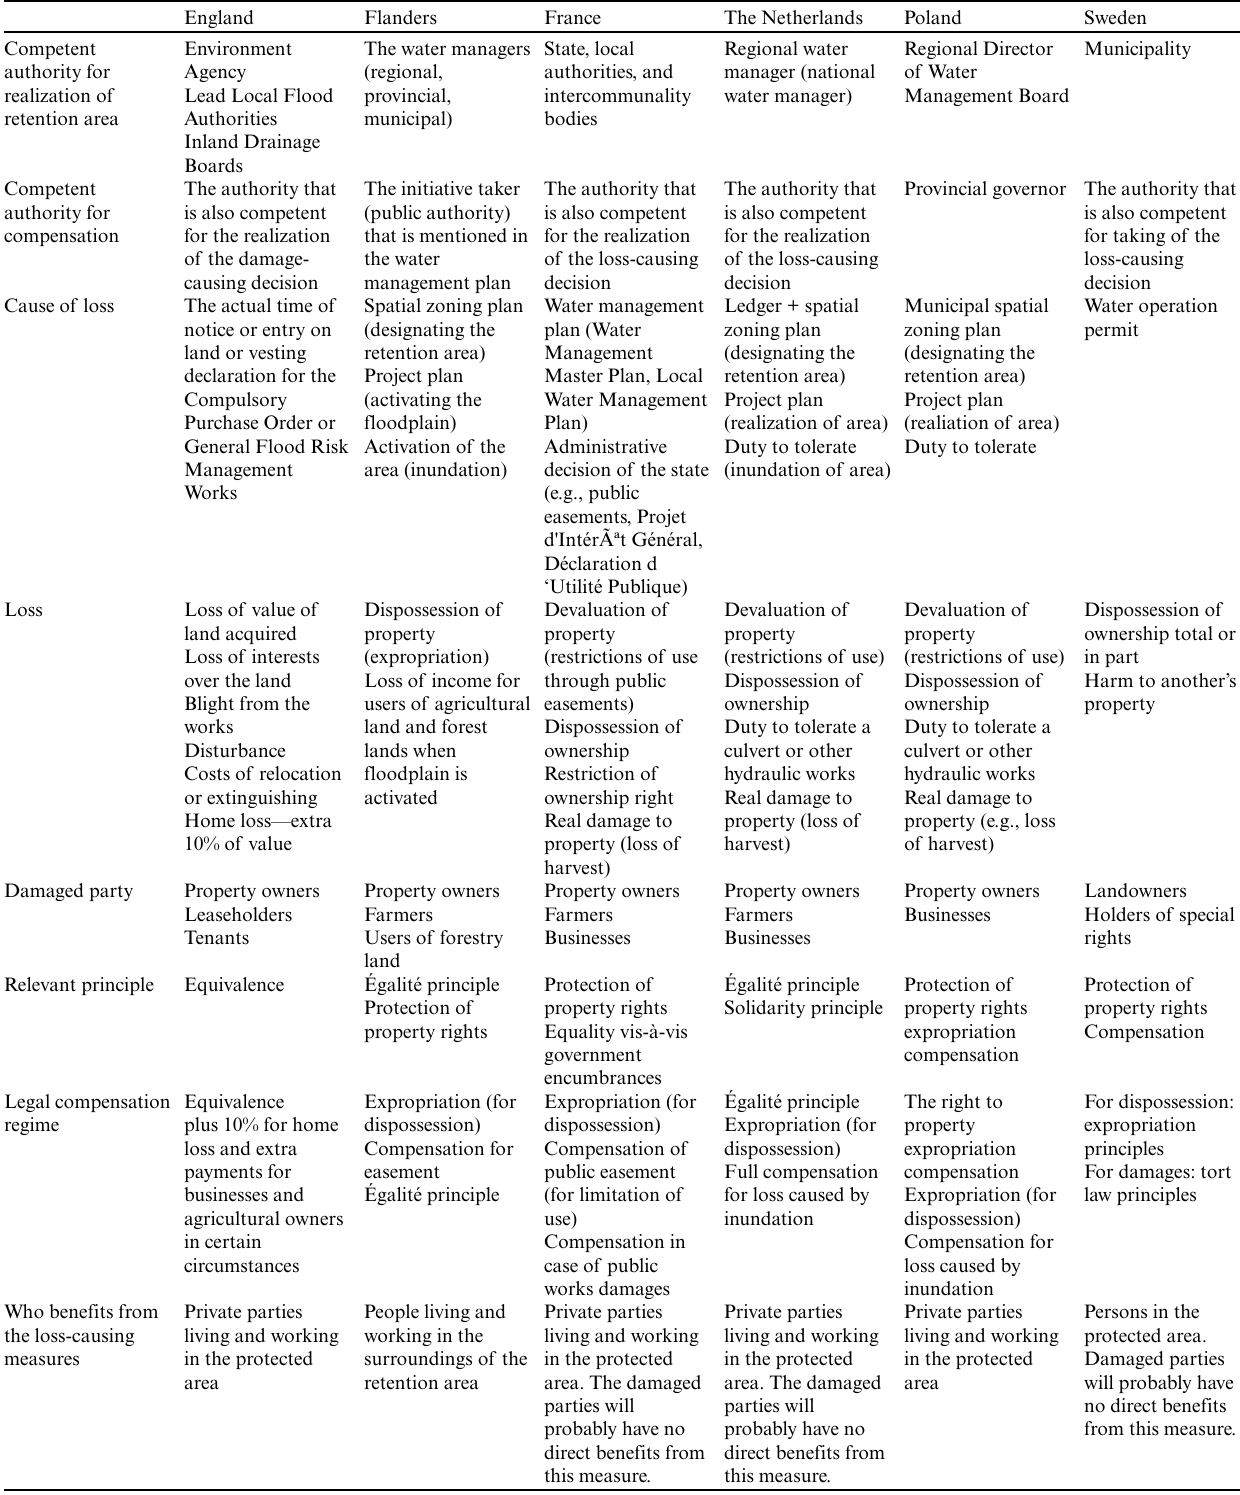
Table 2 . Creation of a retention